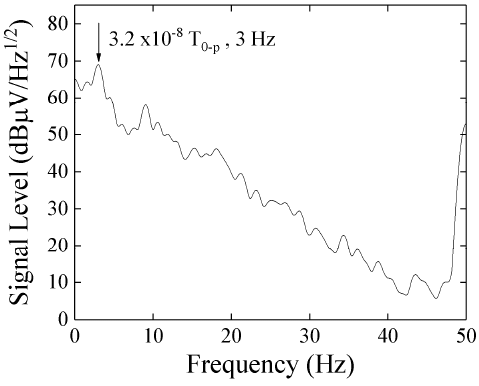
Figure 13. Result of spectrum measurement for a signal of 3.2 × 10 − 8 T 0-P at 3 Hz.